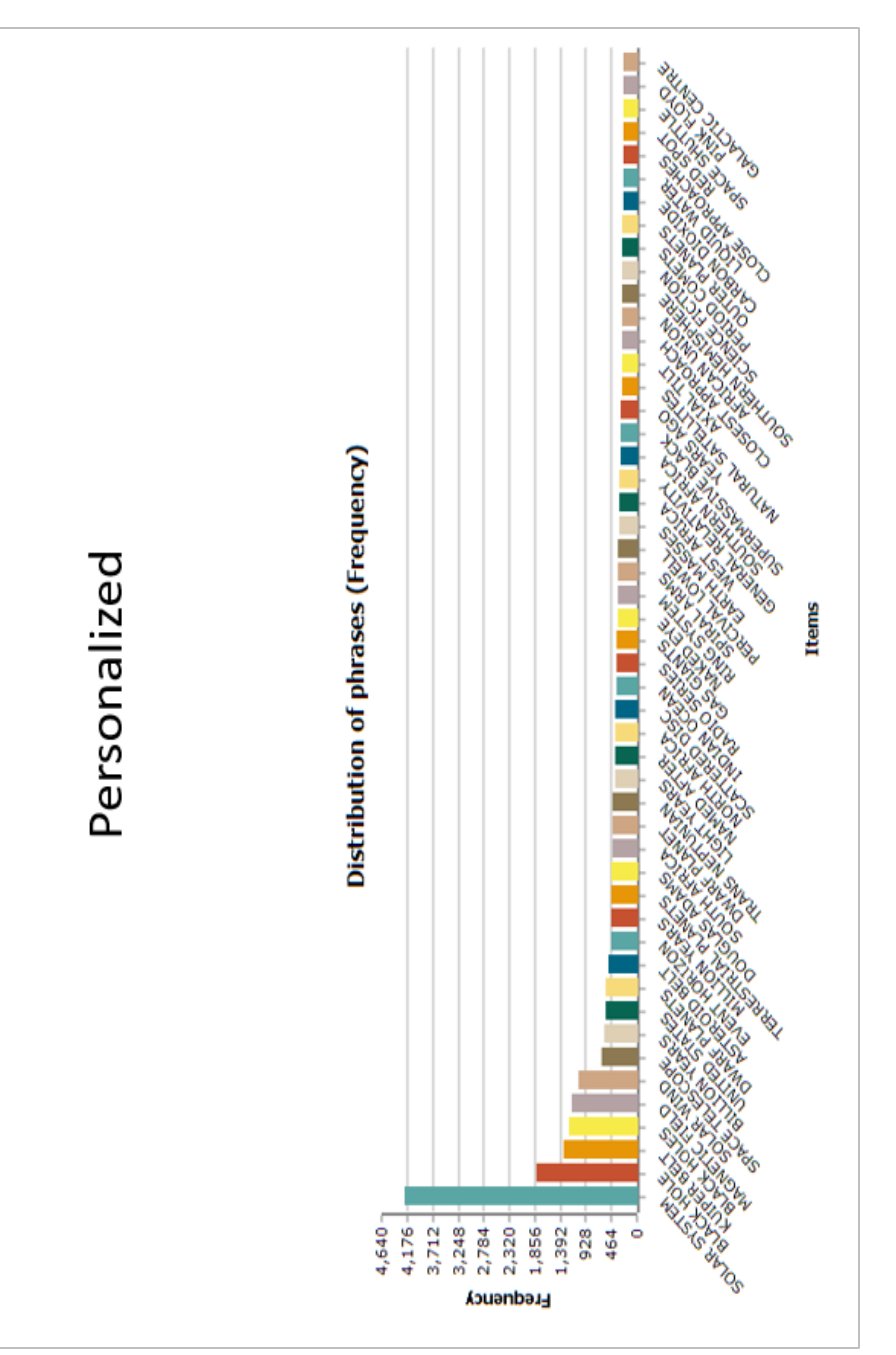
Fig. 9. Distribution of phrases for personalized support